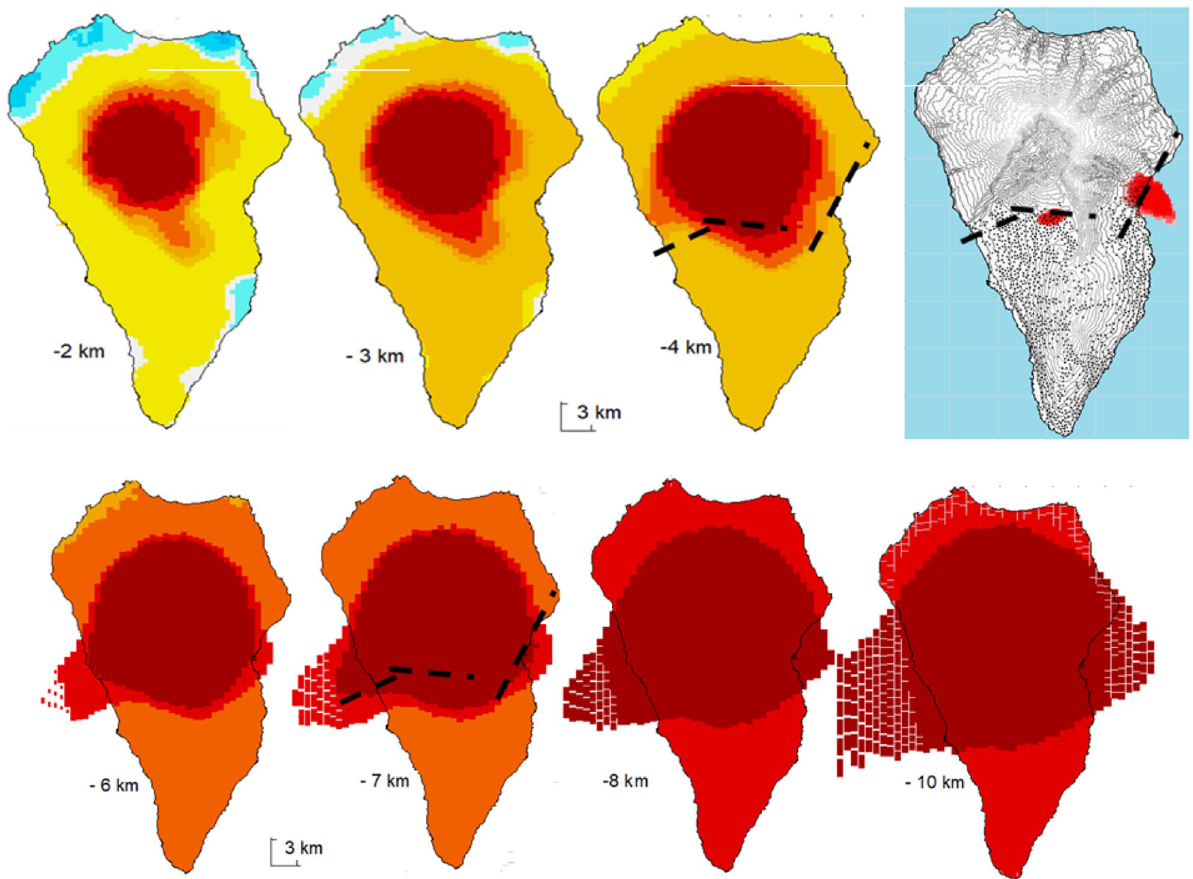
Figure 7. Horizontal sections of the 3D anomalous density structure and location of the 2006–2010 modeled pressure sources. Horizontal sections (from 2 to 10 km bsl) of the 3D model for anomalous density distribution for La Palma Island. Right upper panel shows the structure and the location of the modeled 2006–2010 positive pressure source E-W pattern compared with the structural one at 4 km and 7 km depth as a way of example. Matlab software (www.mathw orks.com) was used to create this